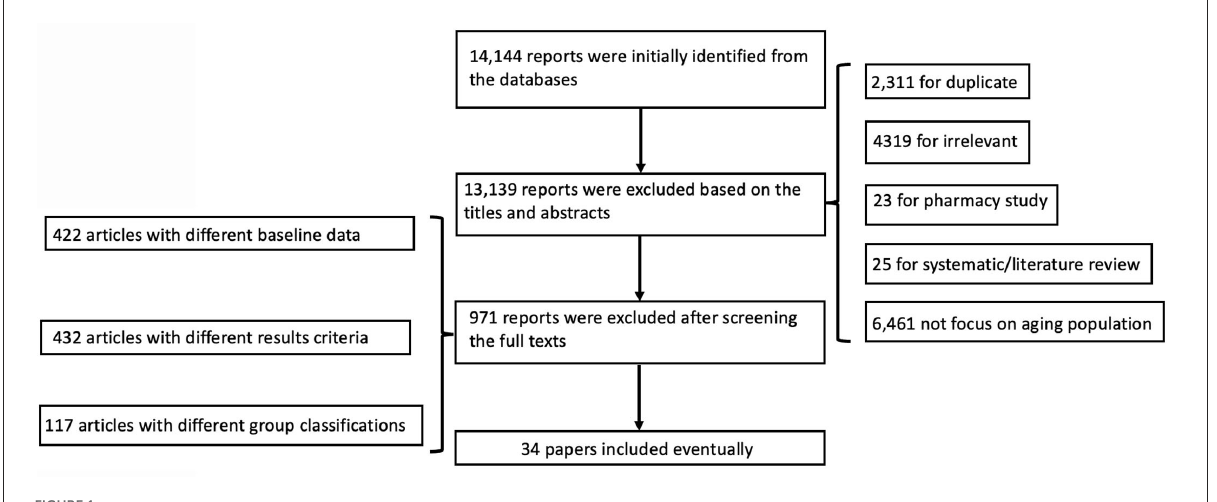
FIGURE1 Flowchart of the literature review process and exclusion criteria.